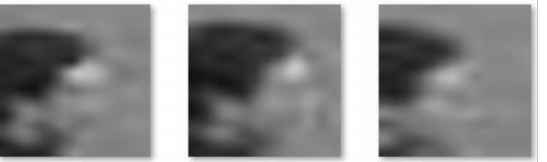
Figure 6. Result samples of LR face region images for one person from video sequences.